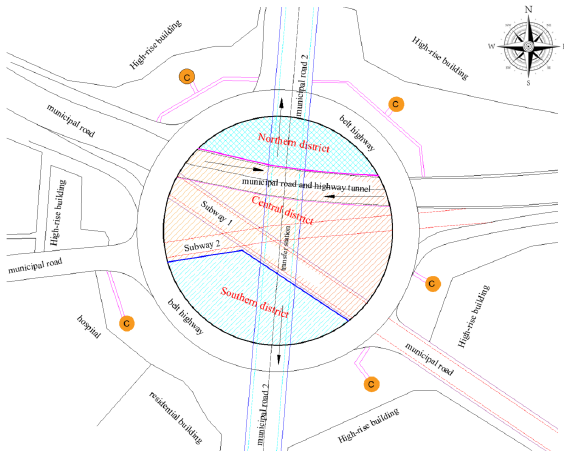
Figure 2. The surrounding environment of foundation pit engineering.